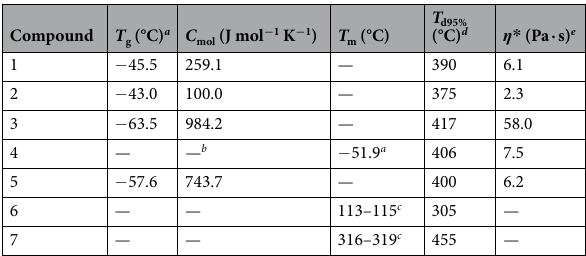
T d95% (°C) d ƞ * (Pa · s) e